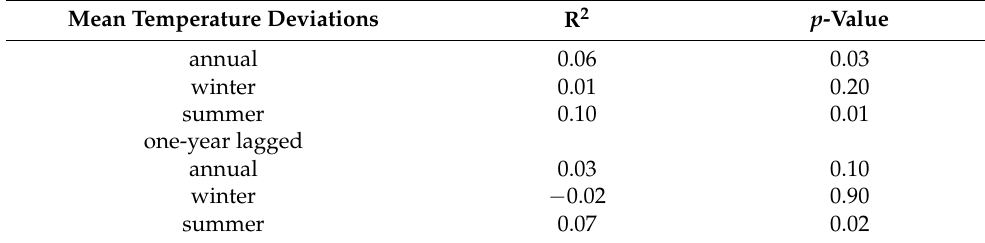
Table 1. Regression analysis showing the effect of insect outbreaks and temperature deviations in Central Europe during the selected study